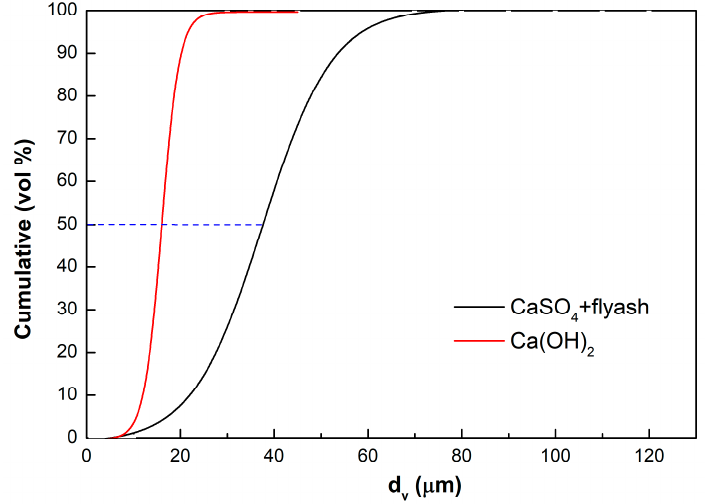
Figure 2. Particle size analysis (Malvern) of the Ca(OH) 2 sorbent used, and of the flyash-CaSO 4 fines collected.